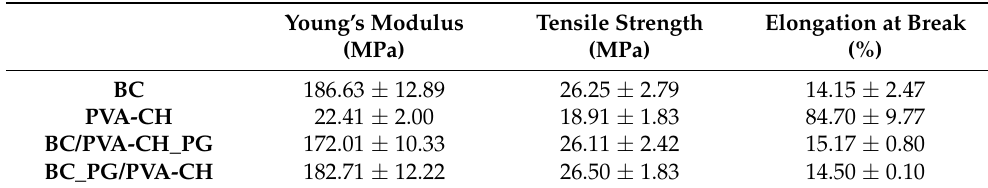
Table 3. Mechanical properties of the individual layers and the double-layered composites produced (data shown as mean ±